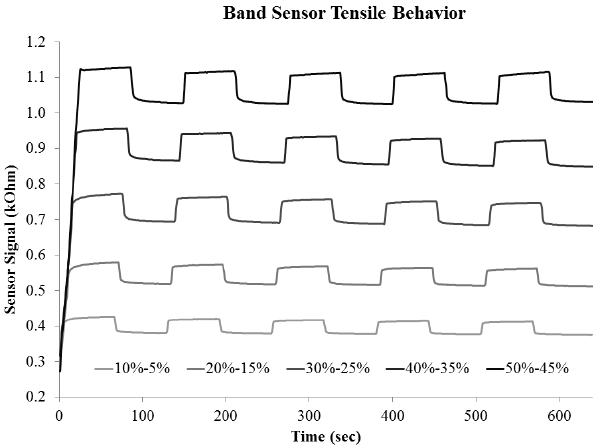
Figure 8. Characteristic band sensor response to tensile strain cycle test. Each sample was first brought to the maximum strain followed by 5% strain range cycling test.